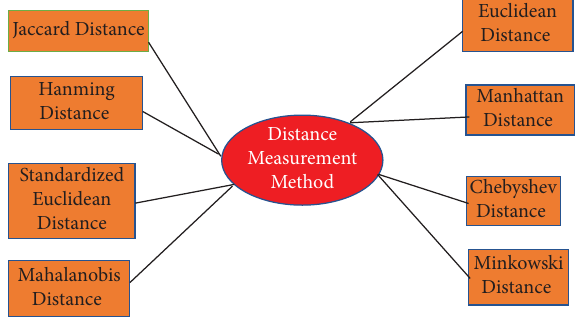
Figure 1: Distance metric